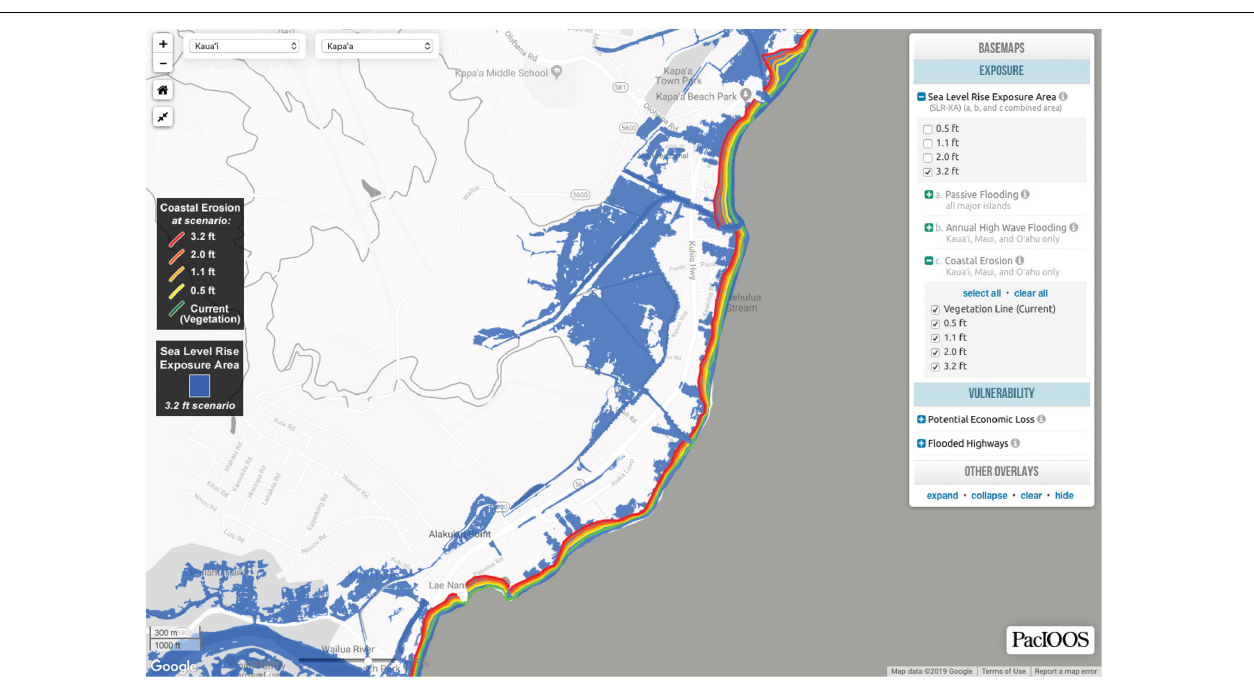
FIGURE 11 | The Hawai‘i Sea Level Rise Viewer that PacIOOS developed is a companion tool to support the State of Hawai‘i Sea Level Rise Vulnerability and Adaptation Report. Policy-makers, planners, homeowners, and the public can explore exposure and vulnerability layers of four sea level rise scenarios. Users can view the geographic extent of three chronic flooding hazards (i.e., passive flooding, annual high wave flooding, and coastal erosion) separately or as an overlay. The image shows the overlay sea level rise exposure layer (dark blue) for the 3.2 ft. sea level rise scenario, and the reach of coastal erosion for each sea level rise scenario (red, orange, yellow, and green lines). Image courtesy of